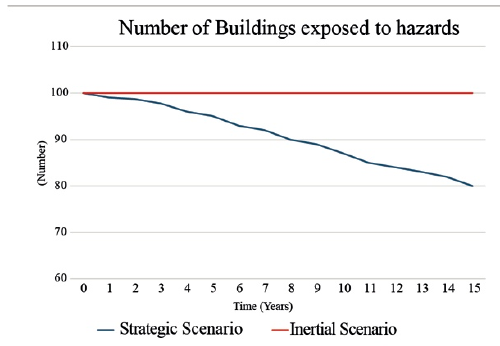
Figure 13. Simulation of the evolution of economic variables over time (Datola et al., 2019) .